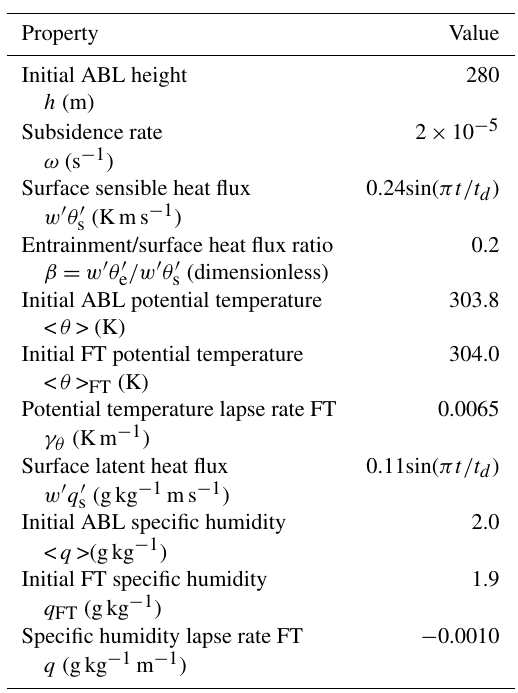
Table 3. The initial and boundary conditions in the atmospheric boundary layer (ABL) and free troposphere (FT) as used in MXL/MESSy. All initial conditions are imposed at 03:00UTC. t is the time elapsed since the start of the simulation ( s ) and t d the length of the simulation ( s ). The subscripts s and e indicate values at the surface and the entrainment zone,